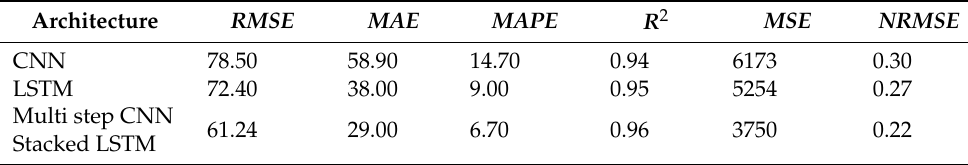
Table 5. Comparison of different DL architectures utilizing POA irradiance data.